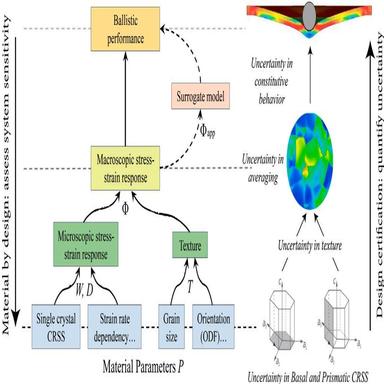
Hierarchical multiscale uncertainty quantification of magnesium.